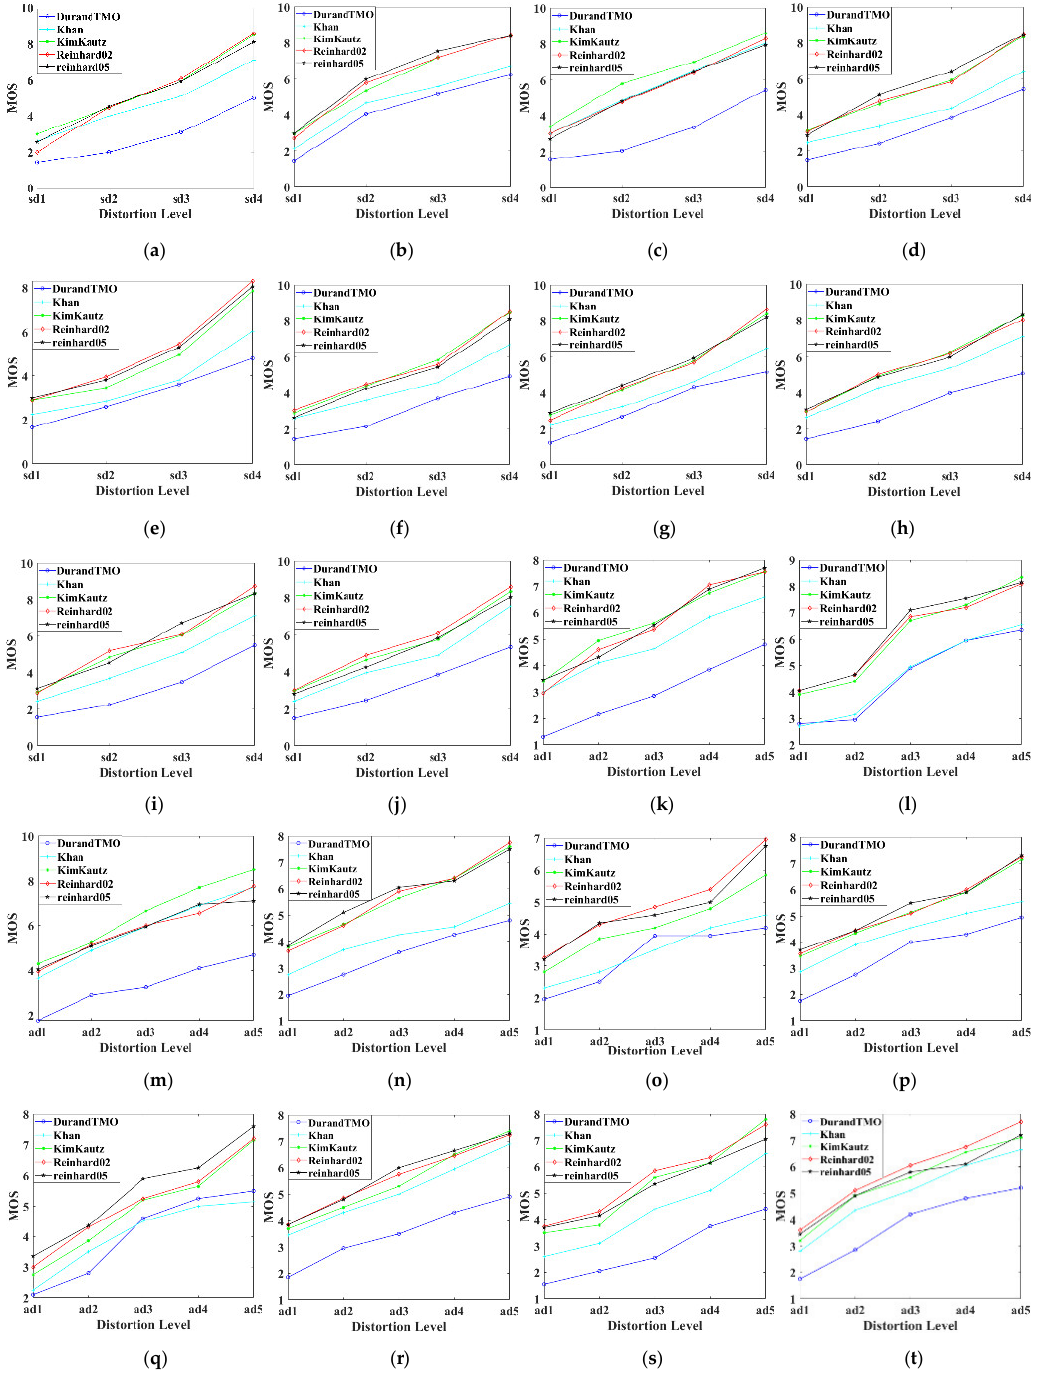
Figure 9. MOS values of the distorted HSOIs in the HSOID dataset. ( a – j ) are symmetric coding distortion, corresponding to ( a – j ); ( k – t ) are asymmetric coding distortion, corresponding to ( a – j ).